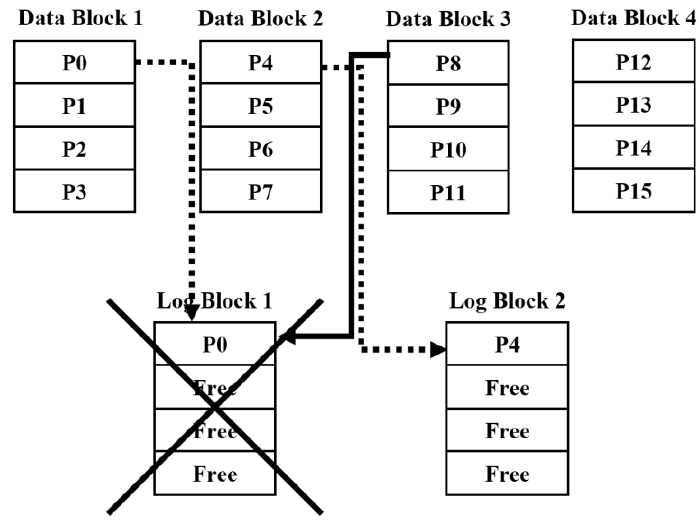
Figure 2. Problem of 1:1 availability.